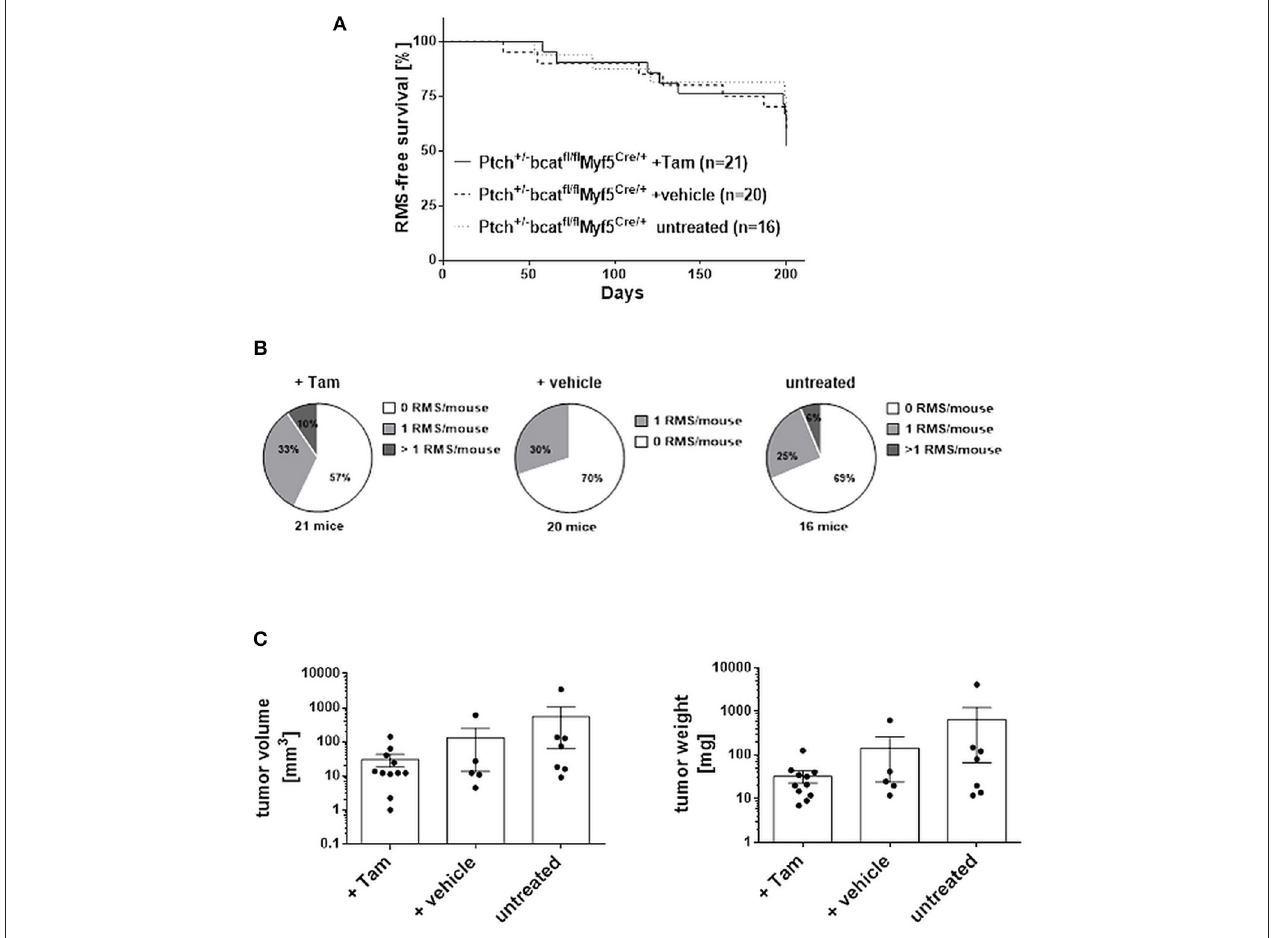
FIGURE 9 | RMS incidence and multiplicity in ß-cat fl / fl Ptch del / + Myf5 CreER / wt animals. (A) Lifetime monitoring of RMS formation. According to Log-rank (Mantel-Cox) test and Gehan-Breslow-Wilcoxon test there were no significant differences. (B) Number of RMS per animal. Chi-square testing shows no significant differences. (C) Tumor volume and weight. One-Way ANOVA with Dunn’s test for multiple comparisons shows no significant differences. Tam: tamoxifen-treated at an age of 4 weeks. Vehicle: vehicle-treated at an age of 4